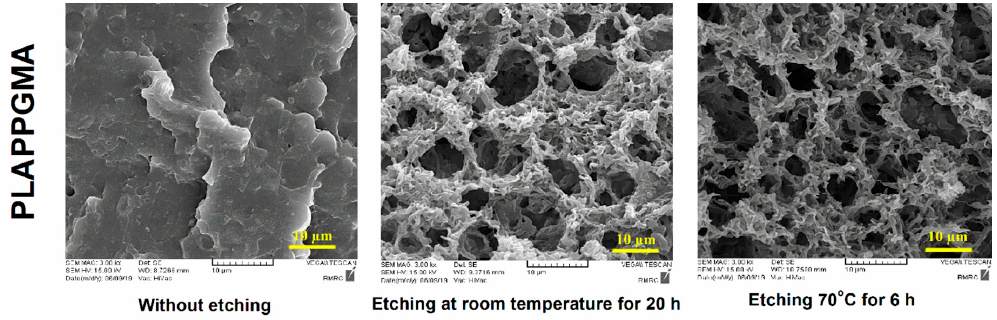
Figure 1. The comparison between different ways of sample etching in xylene.